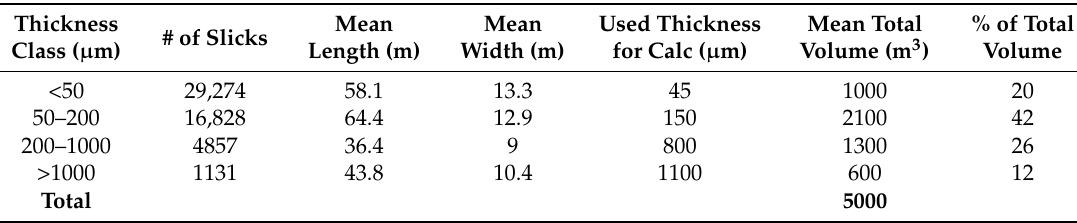
Table 5. Sun et al. [39] Thickness